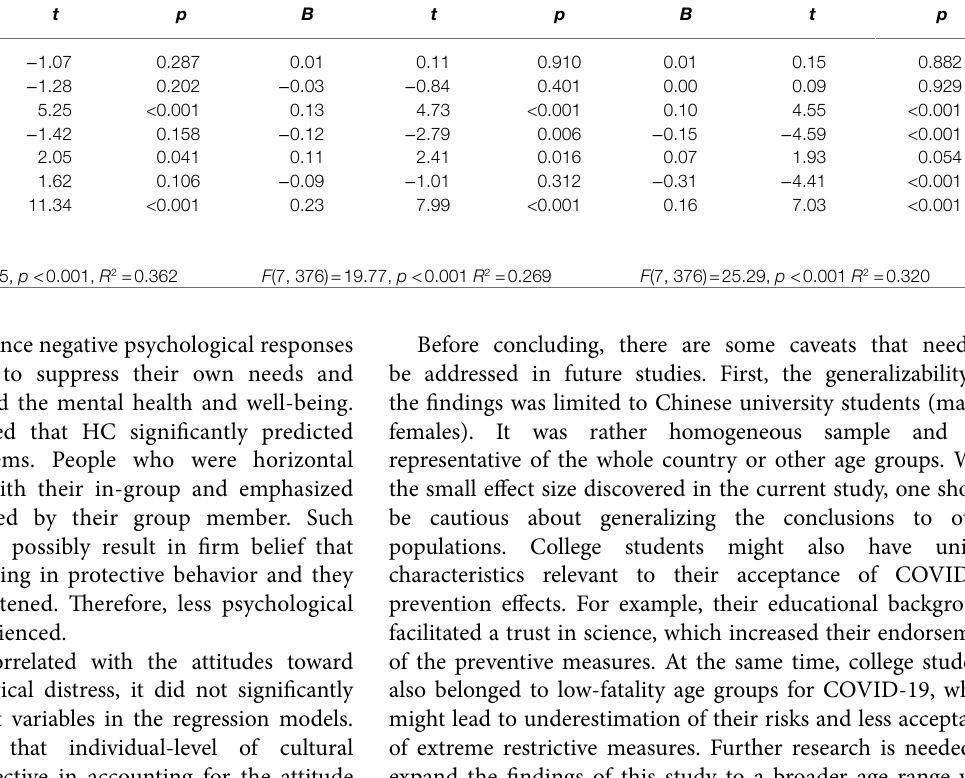
TABLE 4 | Multiple regression models of gender, cultural orientations, trust on respective psychological responses of distress, anxiety, and depression. Predictor Distress